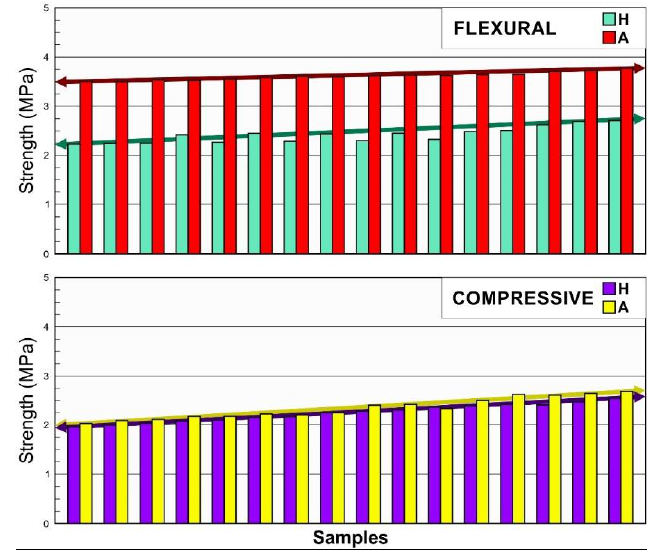
Figure 7. Results of the compressive and bending strength